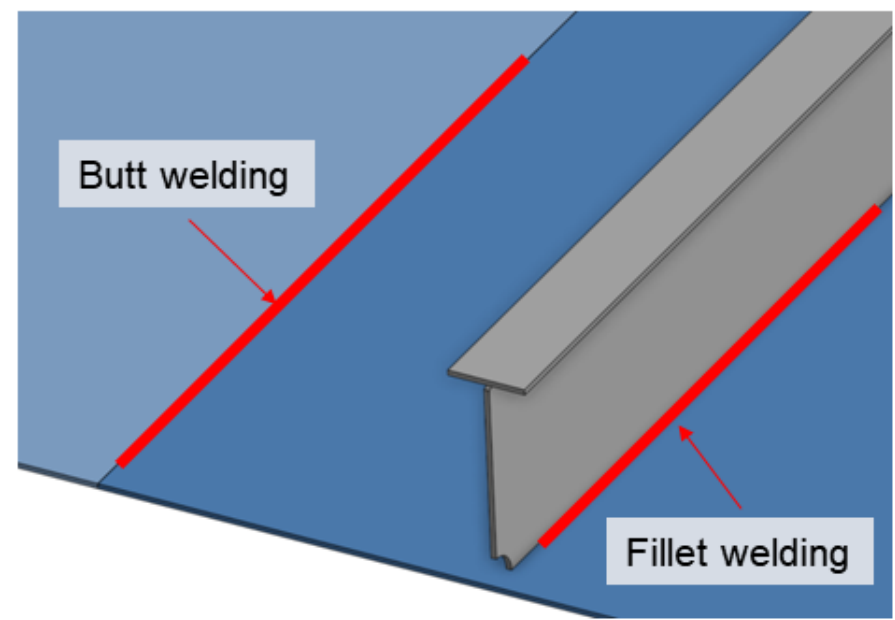
Figure 2. Two welding types employed in the construction of ships and offshore plants.